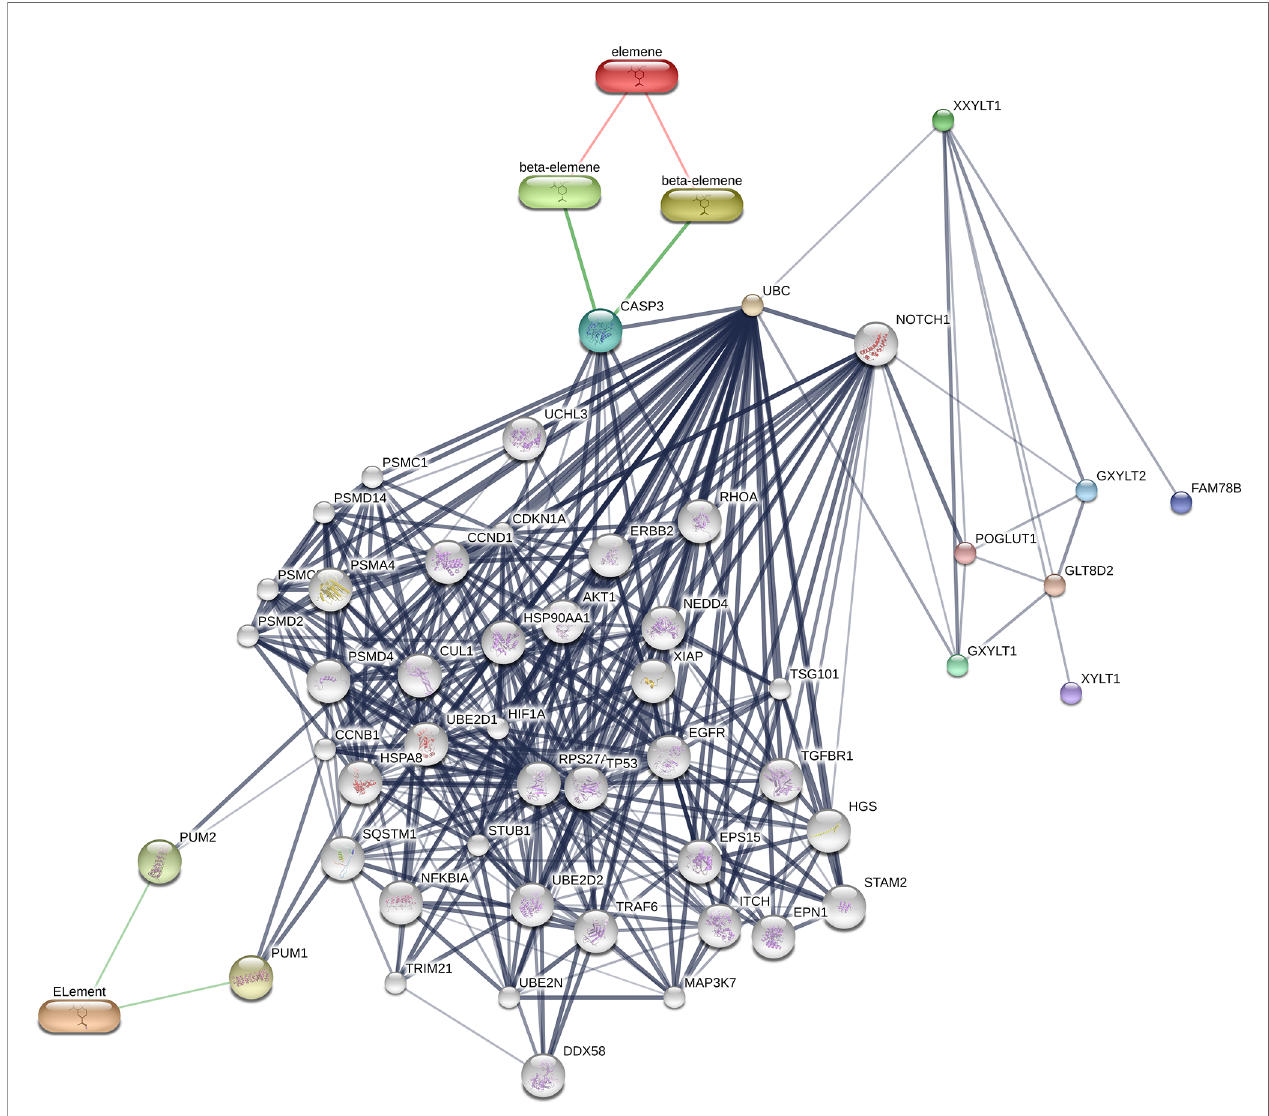
FIGURE 3 | A network of beta-elemene with the potential interacted proteins. Gray lines indicate protein-protein interactions; Green lines indicate compound – protein